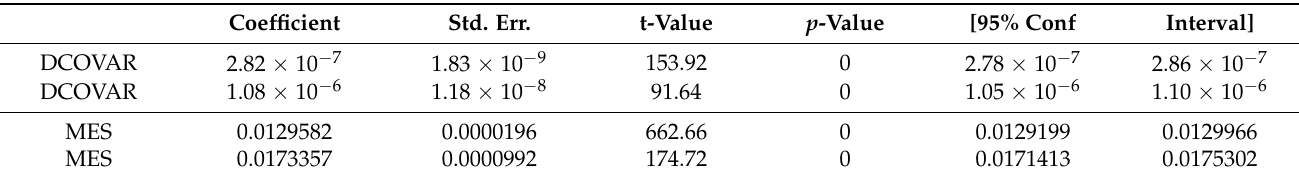
Table 13. Latent class marginal